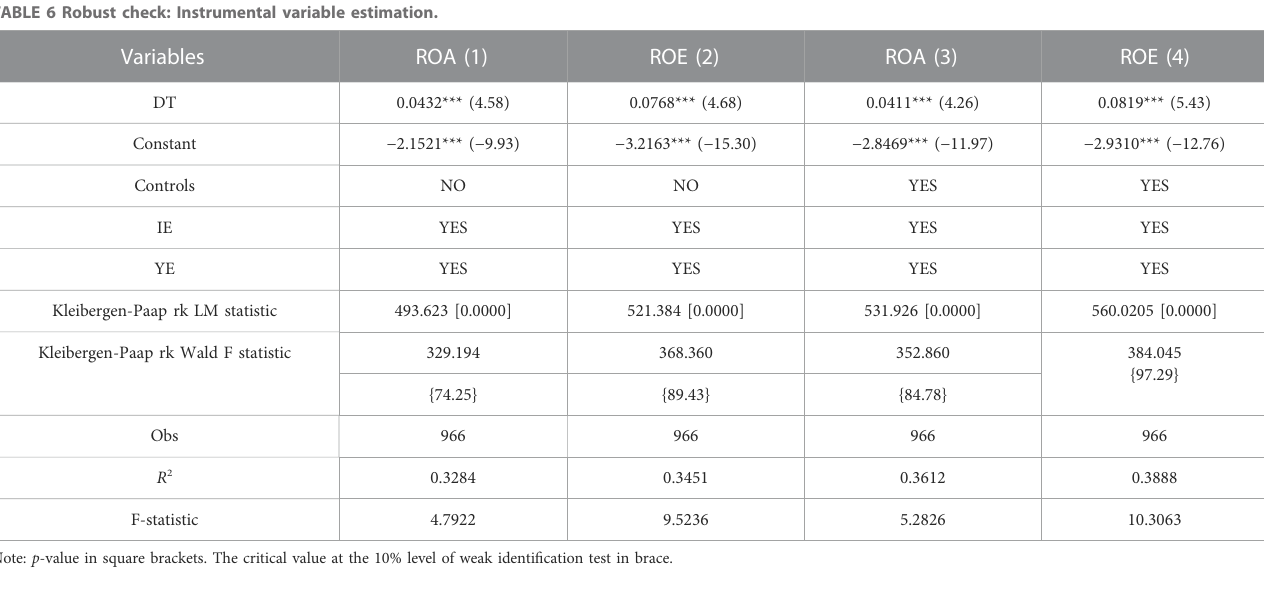
TABLE 7 Heterogeneity analysis of